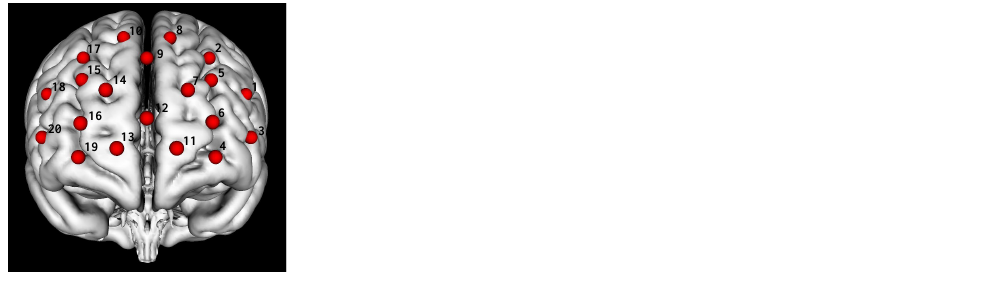
Figure 1. Channel position map. The 20 channels composed of fNIRS optodes were located in the prefrontal area. The red spheres indicate channels and the black numbers show the channel